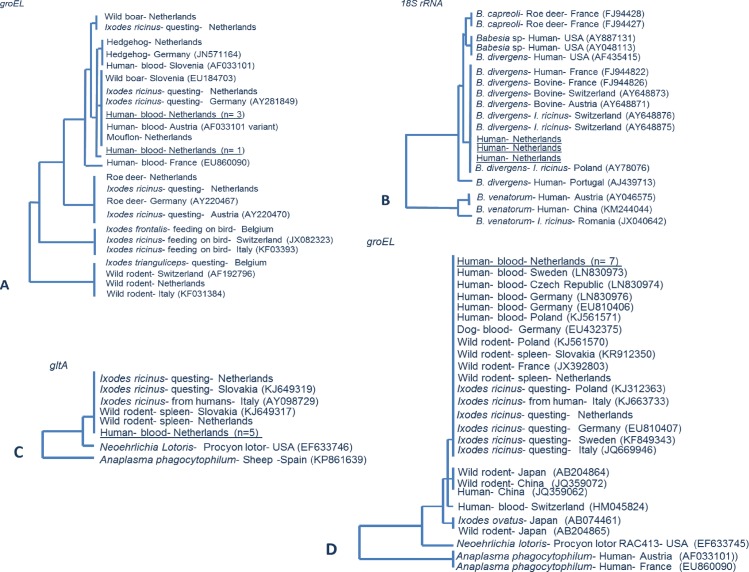
Phylogenetic tree of the sequences obtained from human blood samples.PCR and sequencing was performed on the real-time PCR-positive blood samples. Sequences were clustered with (reference) sequences from Genbank. The evolutionary distance values were determined by Kimura method, and the tree was constructed according to the neighbor-joining method. A.) Anaplasma phagocytophilum: Phylogenetic tree of partial heat shock protein gene groEL of Anaplasma phagocytophilum of the four, one sequences is slightly different by couple of mismatches. All four are part of zoonotic variant of Anaplasma phagocytophilum. B.) Babesia genospecies: Three of the tested blood samples for Babesia genospecies yielded a sequence for the ribosomal 18S rRNA gene, and showed to be identical to B. divergens sequences. C.) Candidatus Neoehrlichia mikurensis: Five out of seven Candidatus Neoehrlichia mikurensis yielded a partial sequence of the citrate synthase gene gltA. D.) Candidatus Neoehrlichia mikurensis: All seven Candidatus Neoehrlichia mikurensis yielded a partial sequence of the heat shock protein gene groEL.